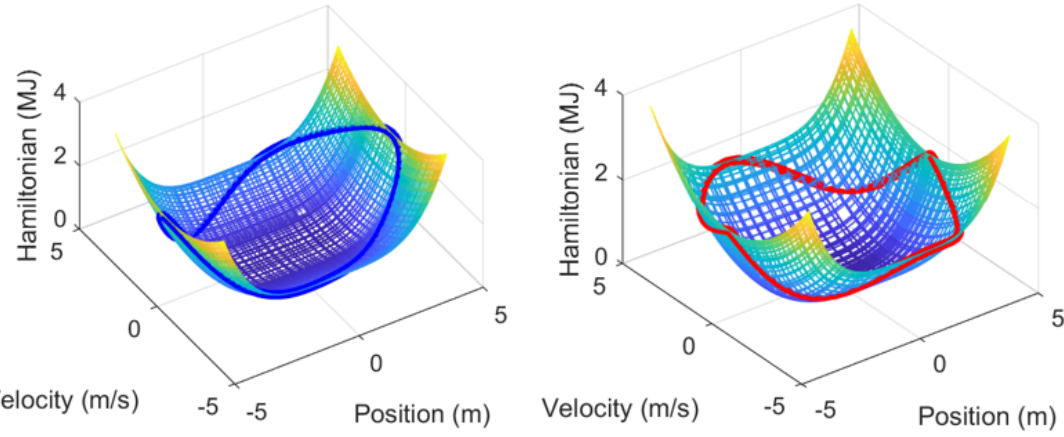
Figure 8. For a single frequency utilizes RCC with nonlinear (NL) cubic spring ( left ) and NL HG ( right ), respectively.